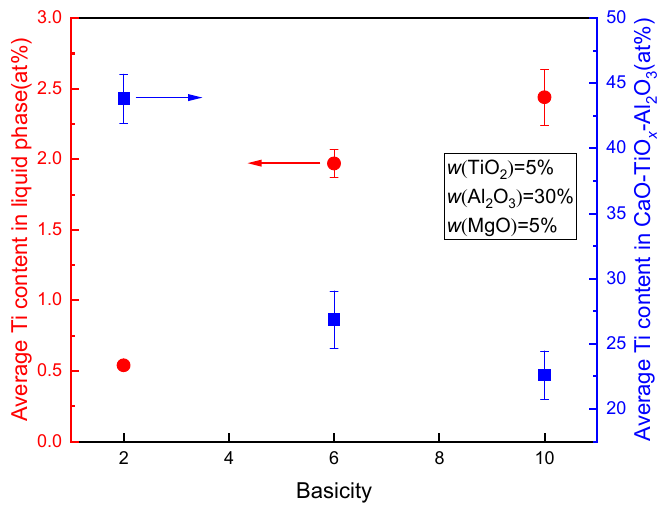
Figure 9. Ti elemental content in the liquid and CTA phases with different slag basicity levels. Table 2. EDS results of different points in Figures 7 and 10